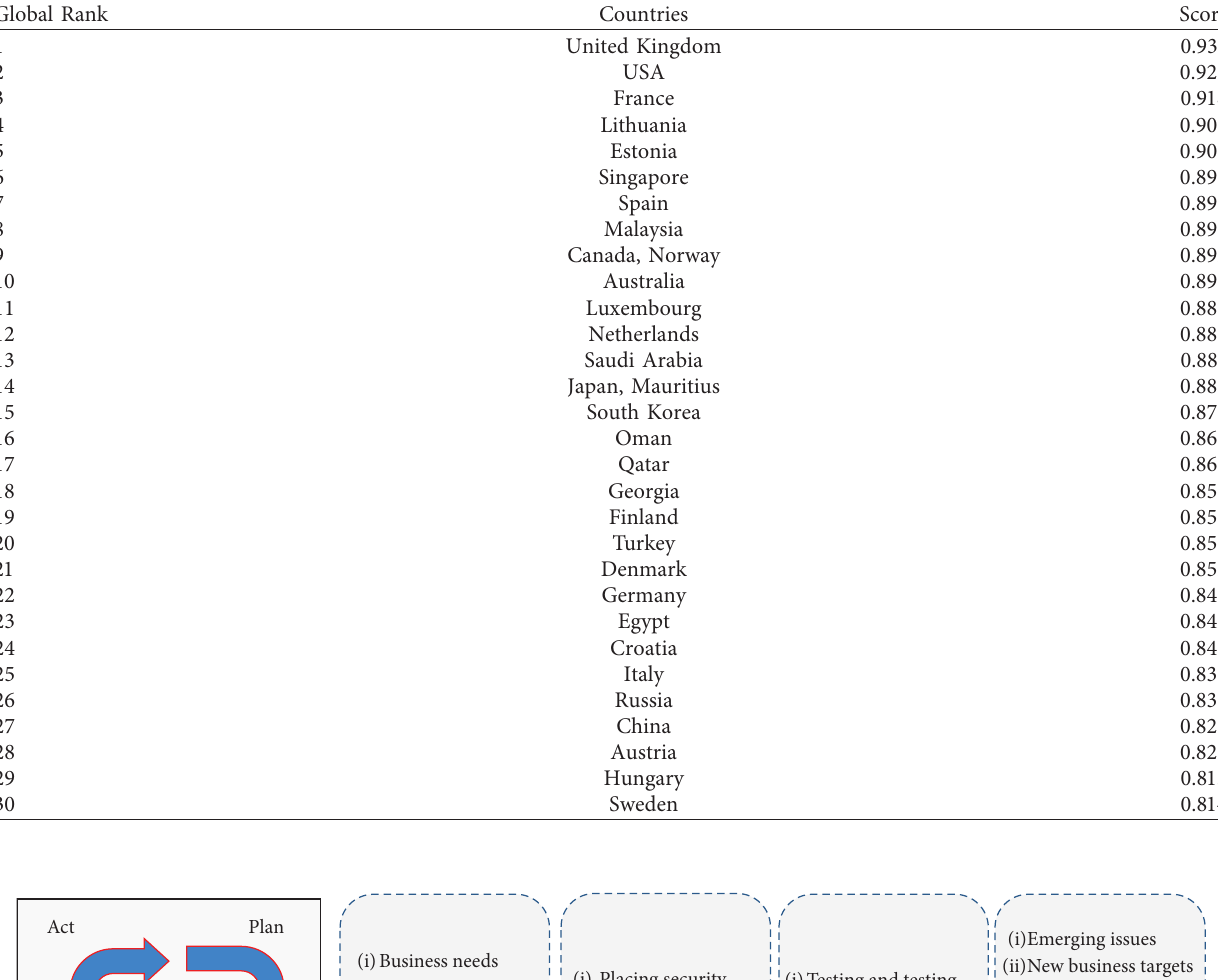
Table 4: ITU global ranking of countries in the field of cyber security